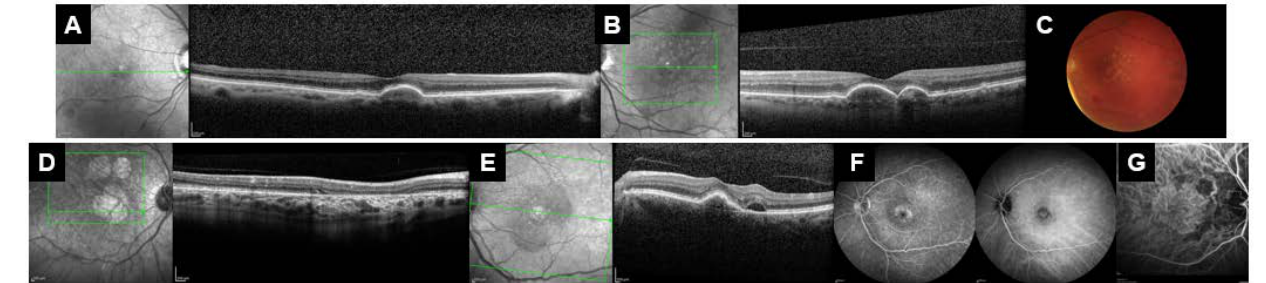
Figure 6. Samples of imagery commonly used to diagnose AMD. ( A , B ) Early AMD infra-red/OCT with serous drusen (lipidic aggregates—see text for details); significant detachment of the pigment epithelium retrofoveolar is also observed. ( C ) Age-related maculopathy retinography with serous drusen. ( D ) Atrophic AMD monitored with infra-red/OCT: macular chorioretinal atrophy ranges and external retinal atrophy with disappearance of the outer nuclear layer. ( E ) Exudative AMD infra-red/OCT: foveolar section showing retinal exudation with detachment of the pigment epithelium, intraretinal oedema and subretinal fluid. ( F ) Fluorescein angiography ( left ) and ICG ( right ) showing an exudative retro-foveolar type 1 neovessel. ( G ) ICG angiography showing a retro-foveolar type 1 neovessel.